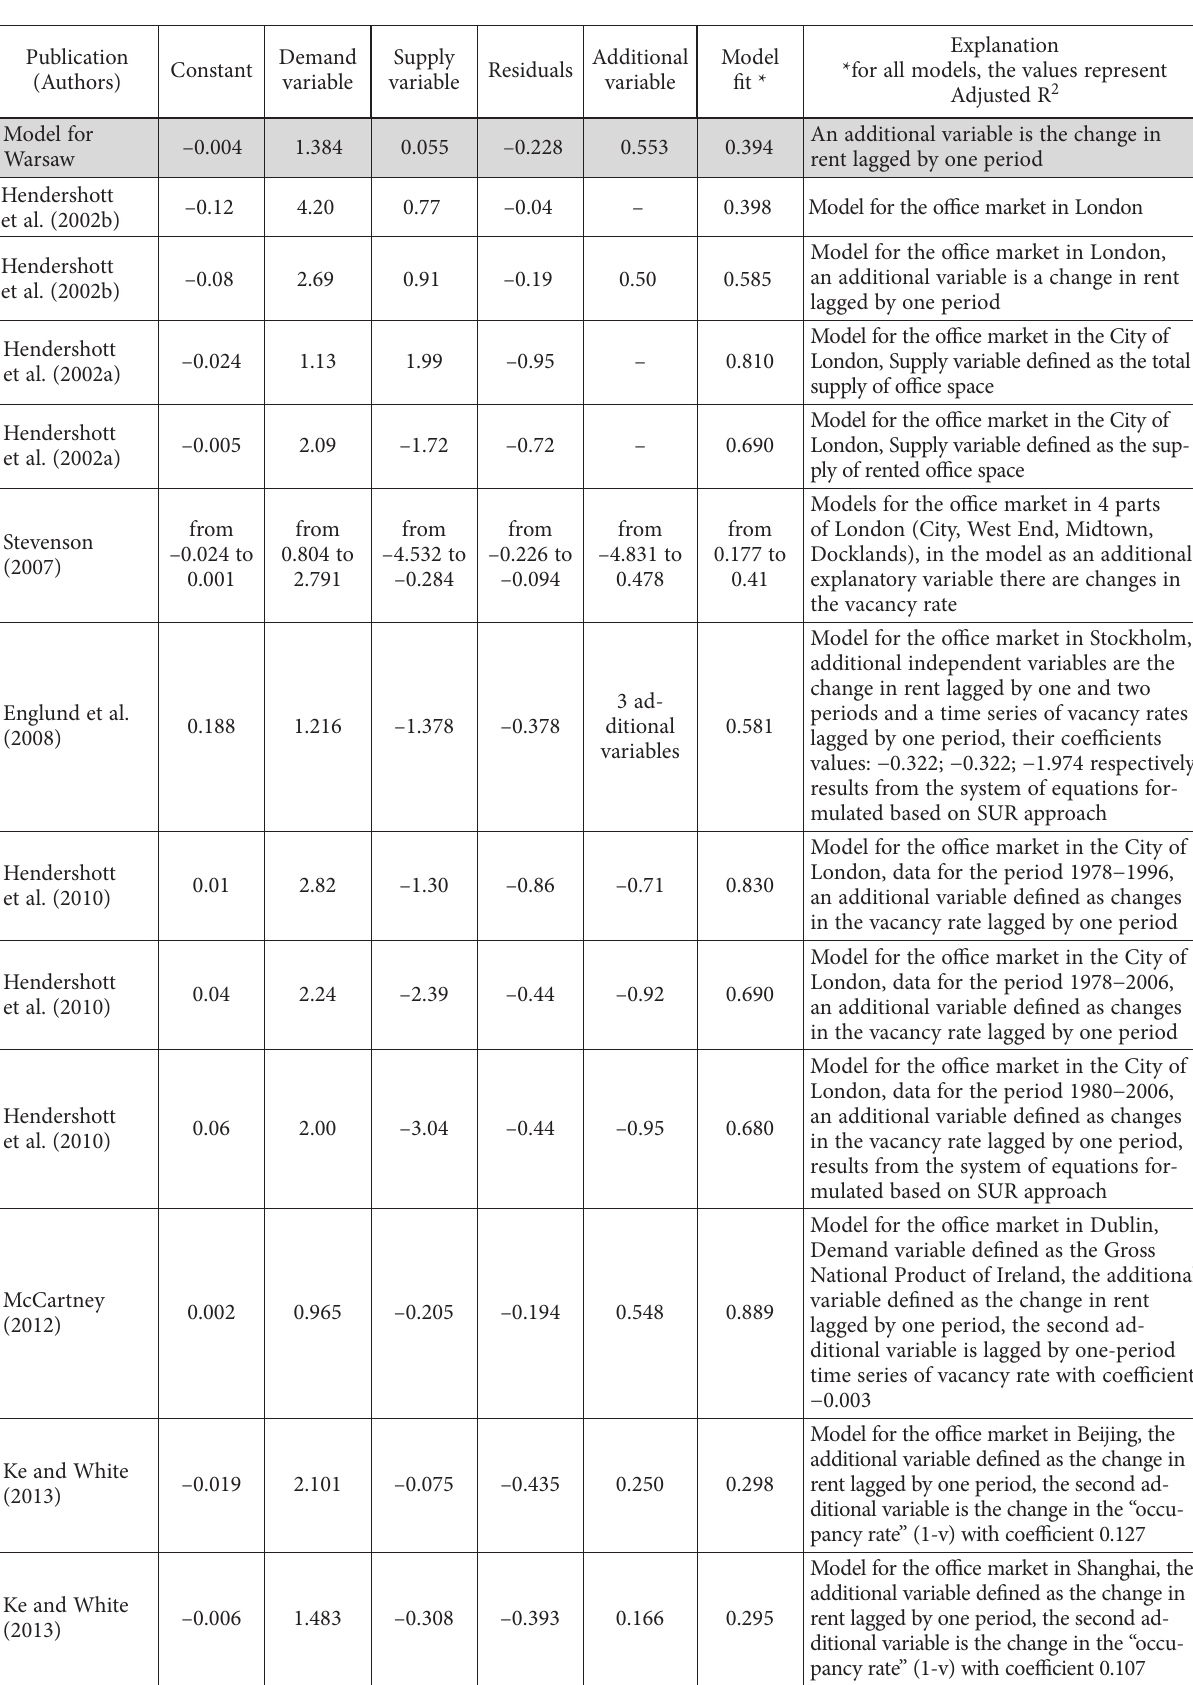
Table 9. Comparison of coefficients of short-term equation of the symmetric model with previous studies (source: own